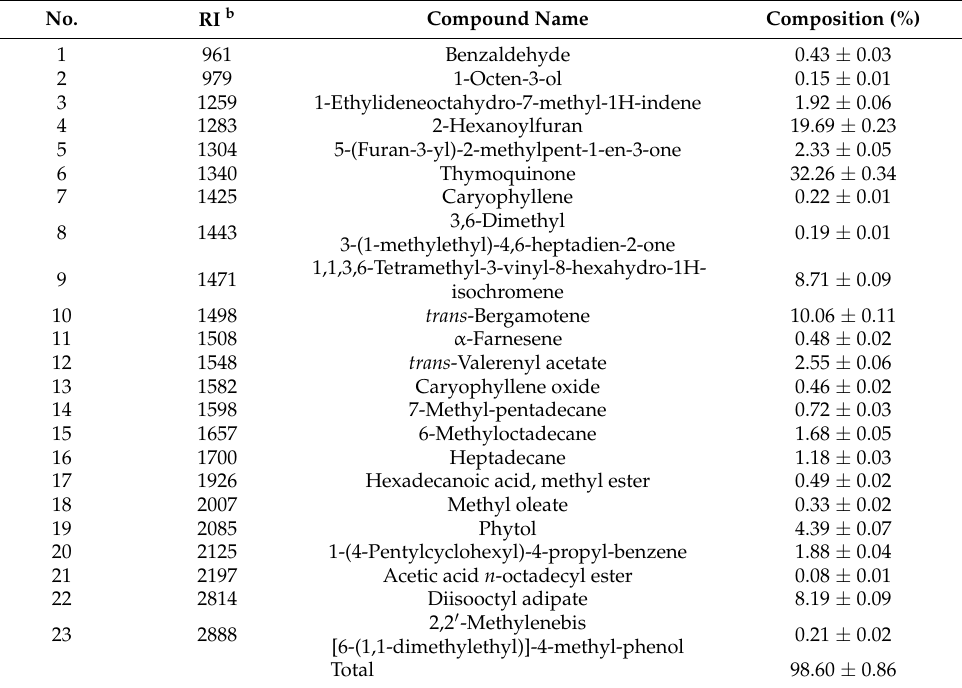
Table 1. Chemical composition of PFEO using GC-FID/GC-MS a . No. RI